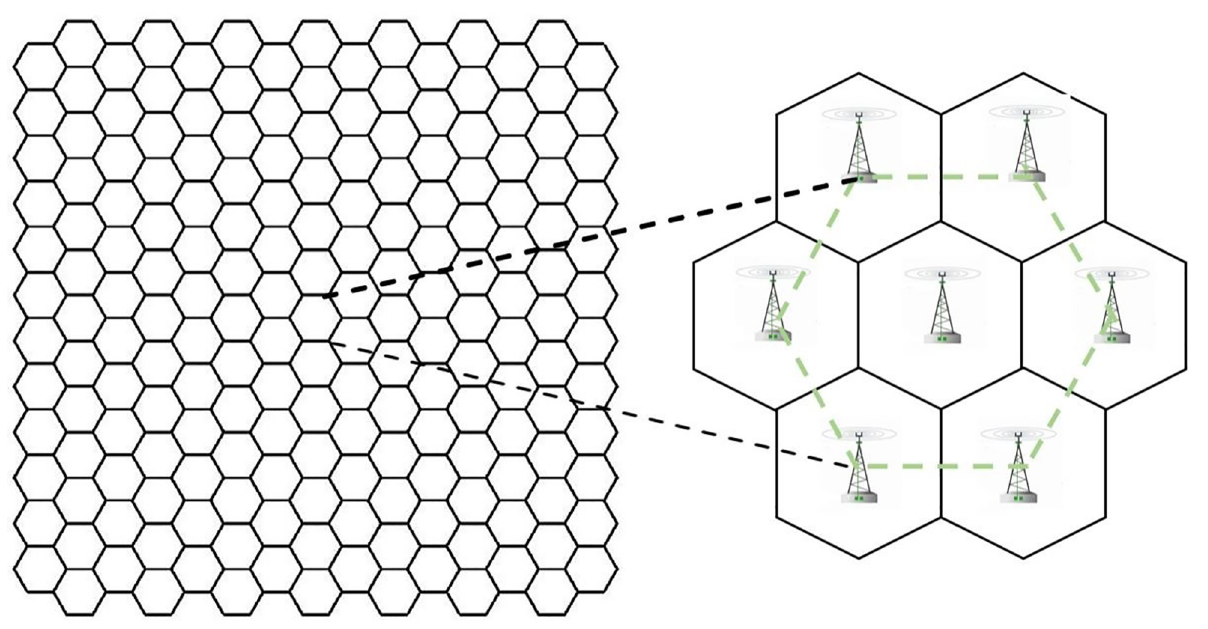
Fig 1. Architecture of conventional cellular